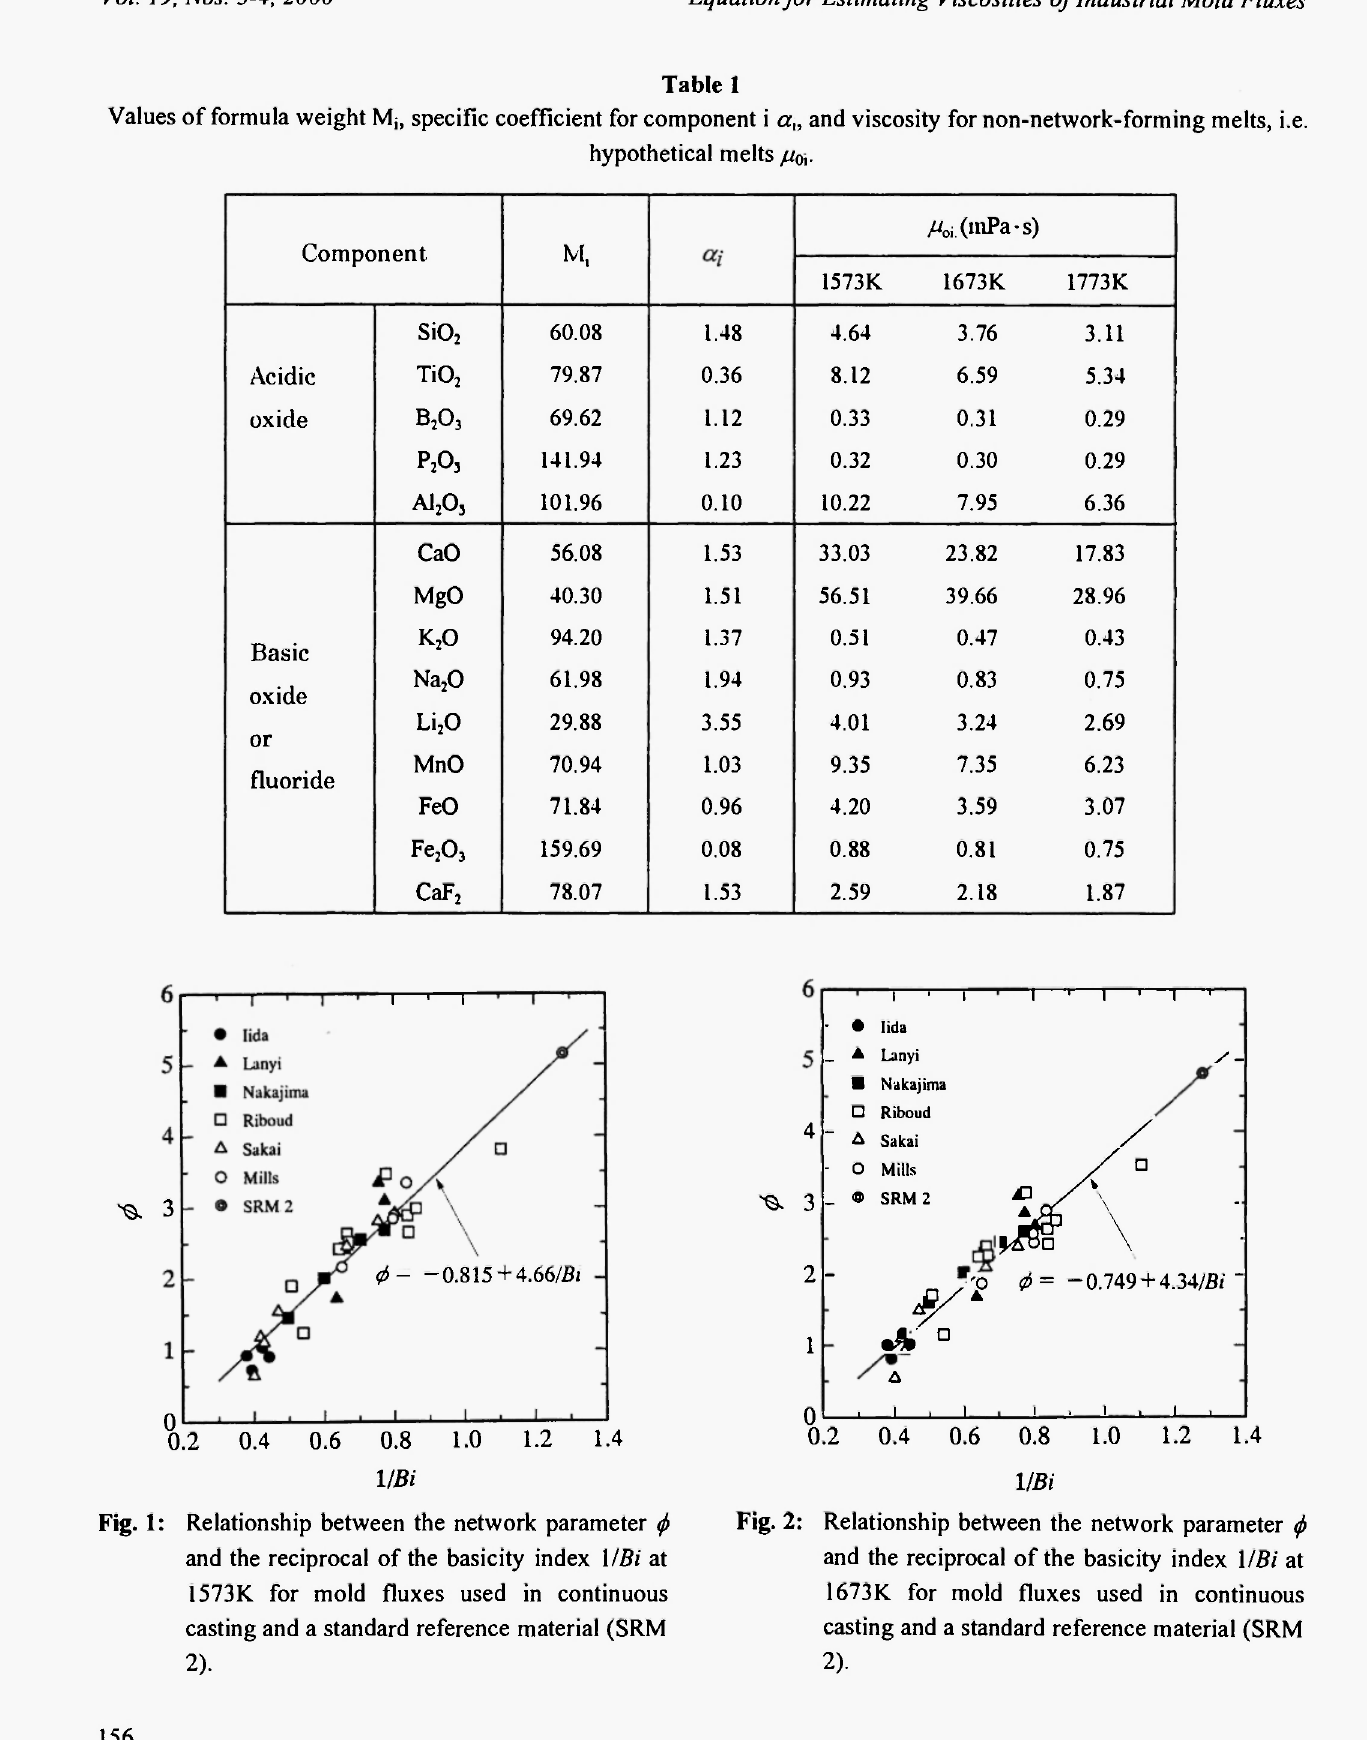
Fig. 2: Relationship between the network parameter φ and the reciprocal of the basicity index MBi at 1673K for mold fluxes used in continuous casting and a standard reference material (SRM